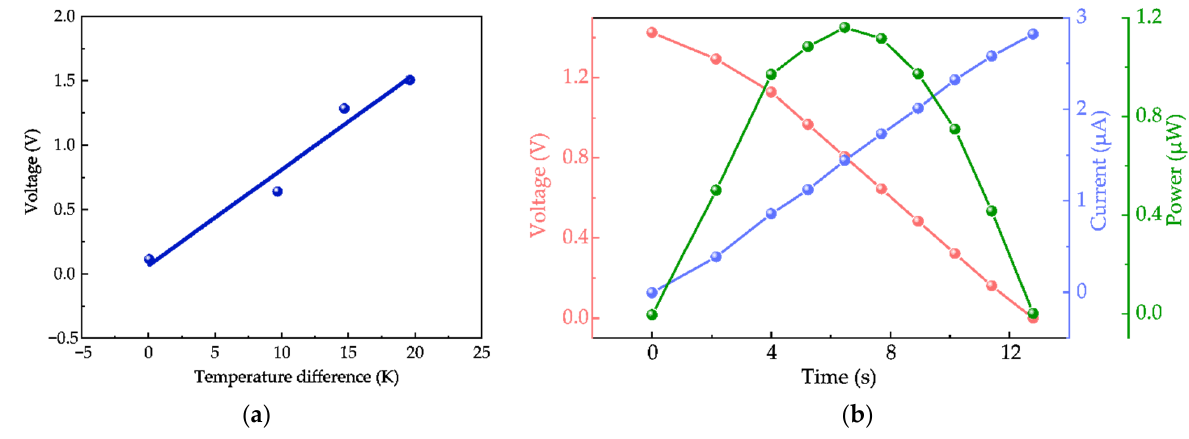
Figure 7. ( a ) The V OC – Δ T curve of the STEG; ( b ) the output voltage–current–power (V-I-P) curves of the STEG scanned by the SMU.